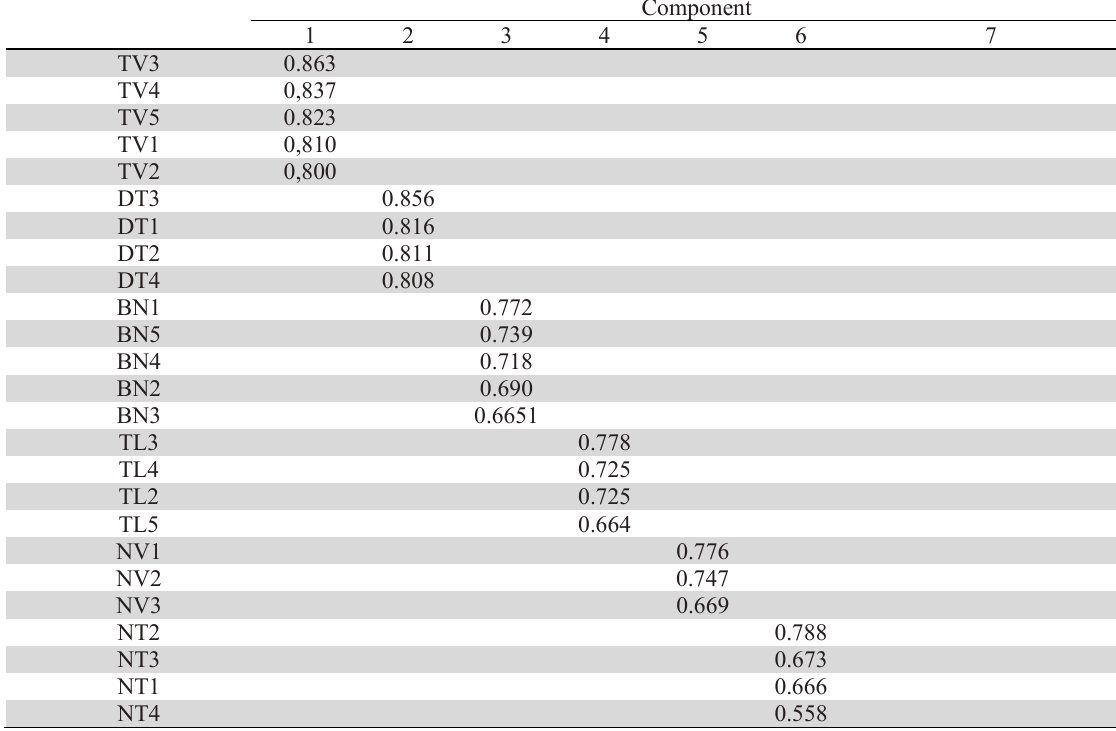
Factor rotation matrix